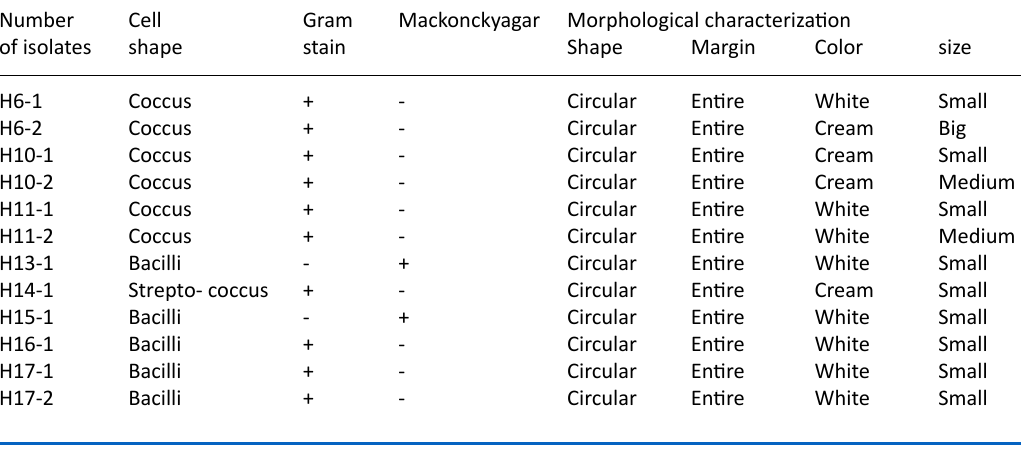
Table 4. Morphological characterization of bacterial isolates from Hungarian